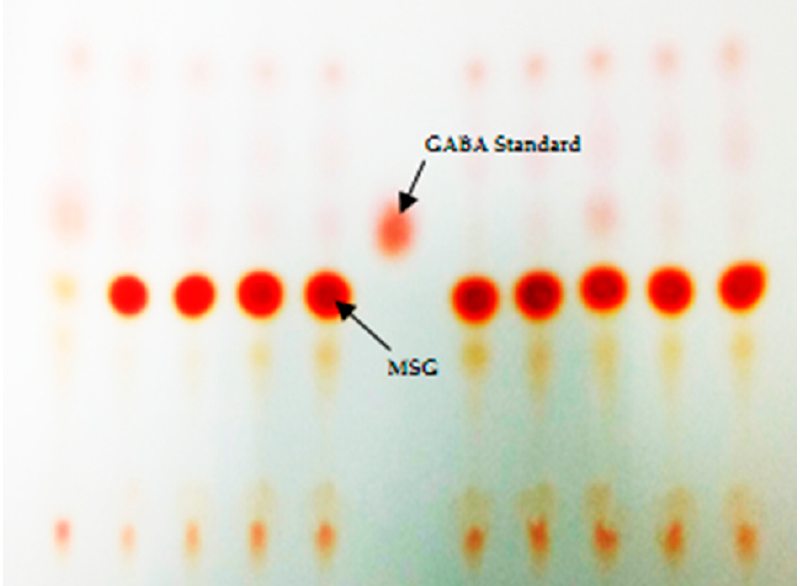
Figure 1. Screening of γ -aminobutyric acid (GABA)-producing lactic acid bacteria (LAB) by the thin-layer chromatography (TLC) method after reacted with ninhydrin solution and heated at 60 °C for 30 min.